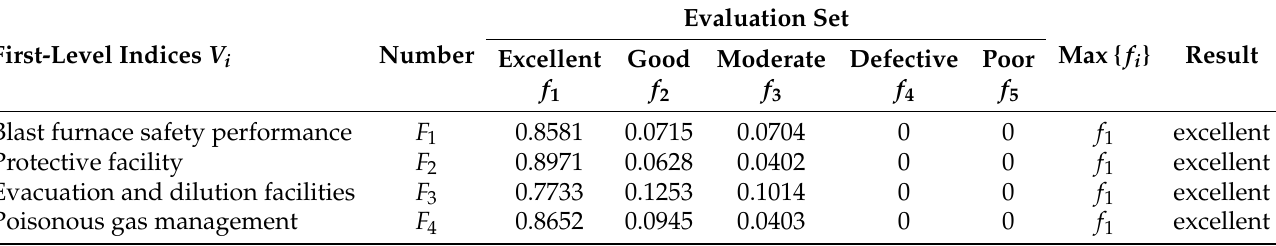
Table 5. The value of evaluation sets of toxic gas